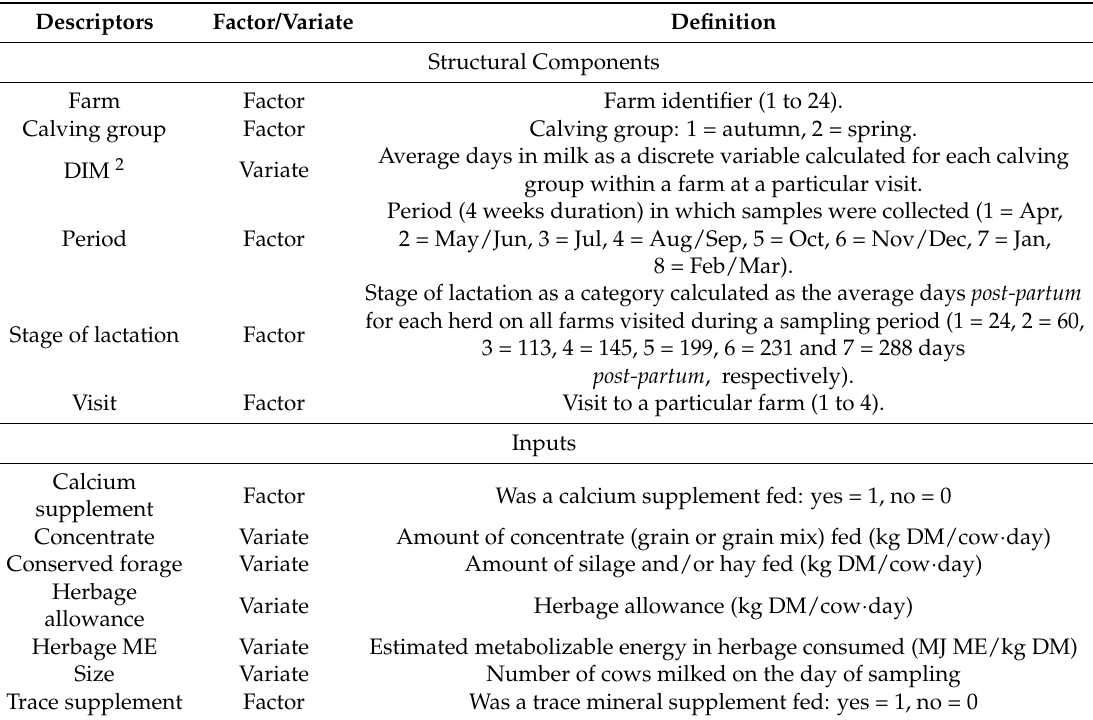
Table 2. Descriptors used to define the management structure of dairy farms in the study 1 .